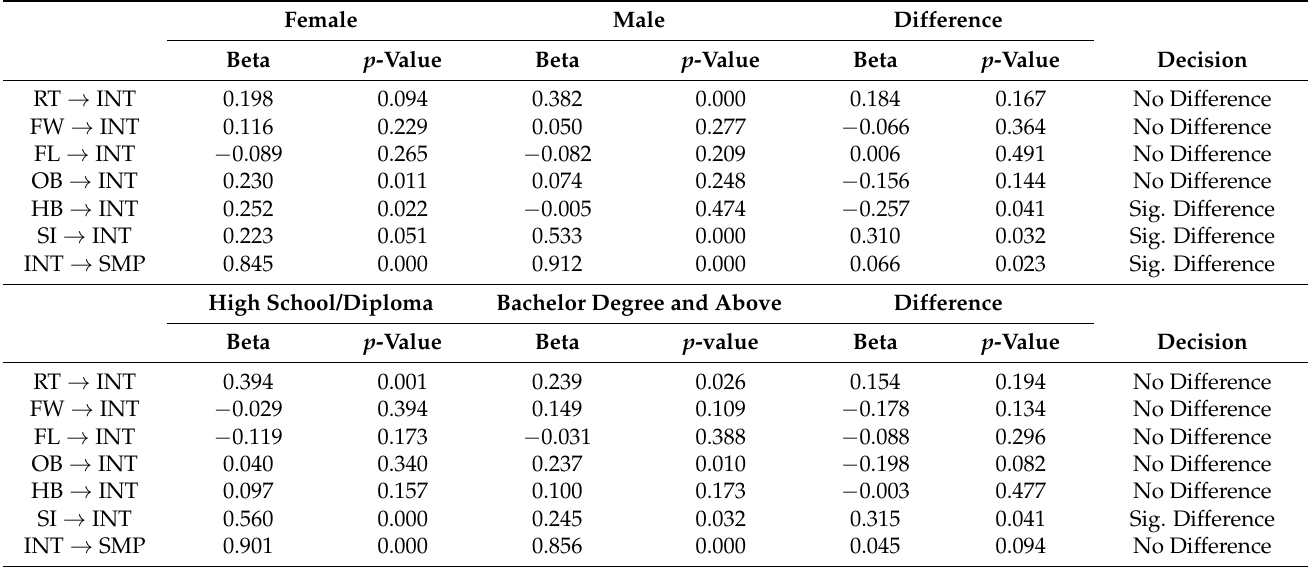
Table 7. Multi-group